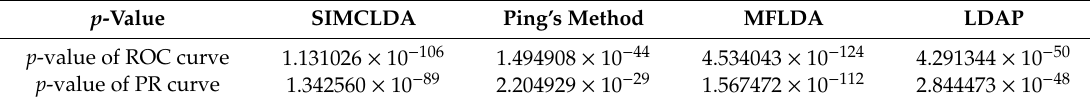
Table 3. A pairwise comparison with a paired Wilcoxon-test on the prediction results.